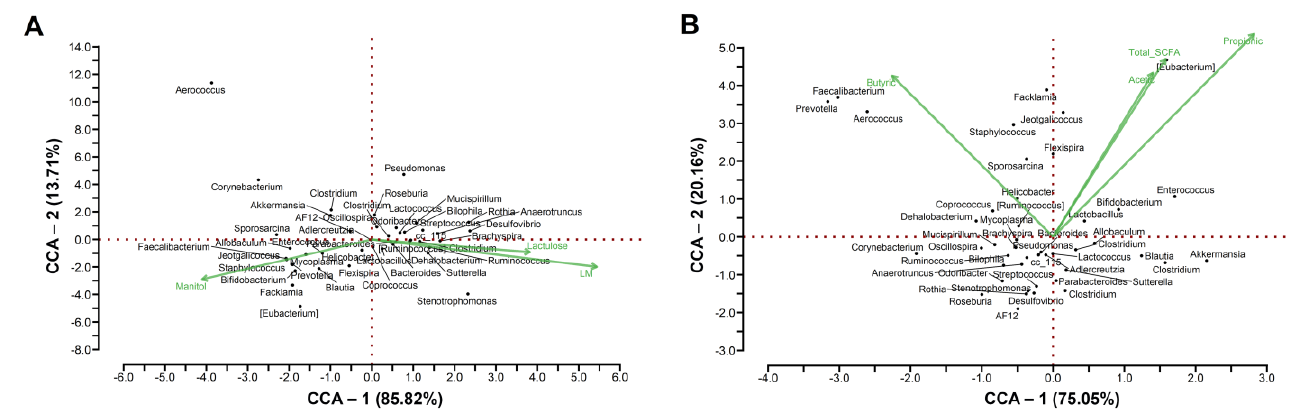
Figure 4. Canonical correspondence analysis (CCA) among groups treated with LG-G12. CCA was performed on the most abundant OTUs (relative abundance > 0.1%) at the genus level for the groups G3 and G7, with ( A ) the intestinal permeability parameters (lactulose, mannitol, and lactulose/mannitol ratio) and ( B ) the short-chain fatty acids acetate, propionate, butyrate, and total SCFA. Green lines indicate the direction and magnitude of measurable variables associated with community structures. Table 3. Short-chain fatty acid (SCFA) concentration (µmol/g feces) in caecal samples and lactu- lose/mannitol ratio (L/M) obtained across the different groups after their respective intervention in phase 2 (treatment phase).